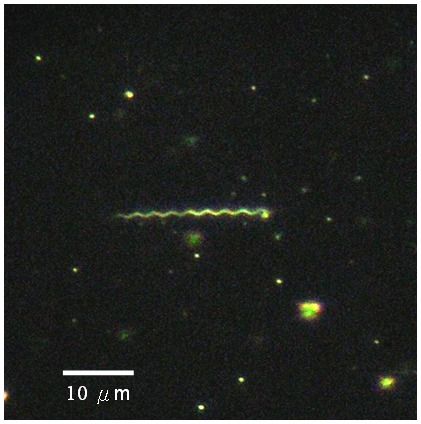
Light micrograph of pure isolate of Borrelia spirochete observed in culture medium at 3 to 7 days after filtrated passage.